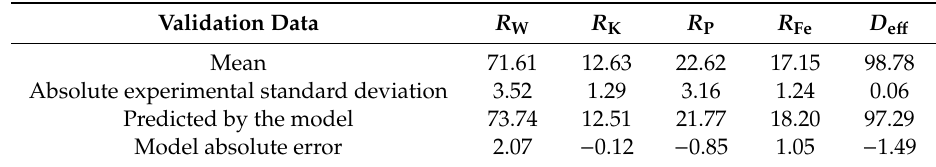
Table 9 . Validation test for the Falcon SB based on a test with optimized parameters ( ω = 58 Hz; % S =